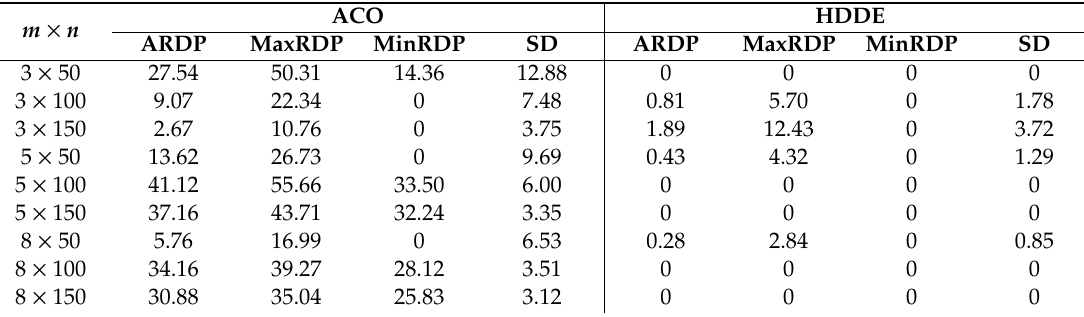
Table 8. Comparison between HDDE and ACO.